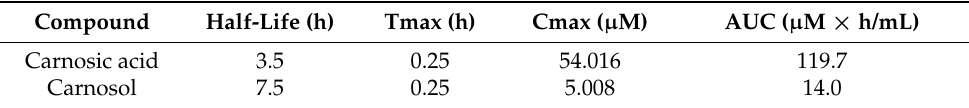
Figure 2. Concentration curve of the pharmacokinetic profile of ( A ) carnosic acid and ( B ) carnosol when administered as rosemary extract (RE) in mice. Mice were given 100 mg/kg of oil-soluble RE by oral gavage, and blood was drawn at time points of 0.25, 0.5, 1, 2, 4, 6, 12, and 24 h. The plasma was separated and analyzed by LC–MS/MS. The pharmacokinetic parameters determined from the study are found in Table 1. Table 1. Pharmacokinetic parameters of carnosic acid and carnosol from rosemary extract (100 mg/kg). Compound